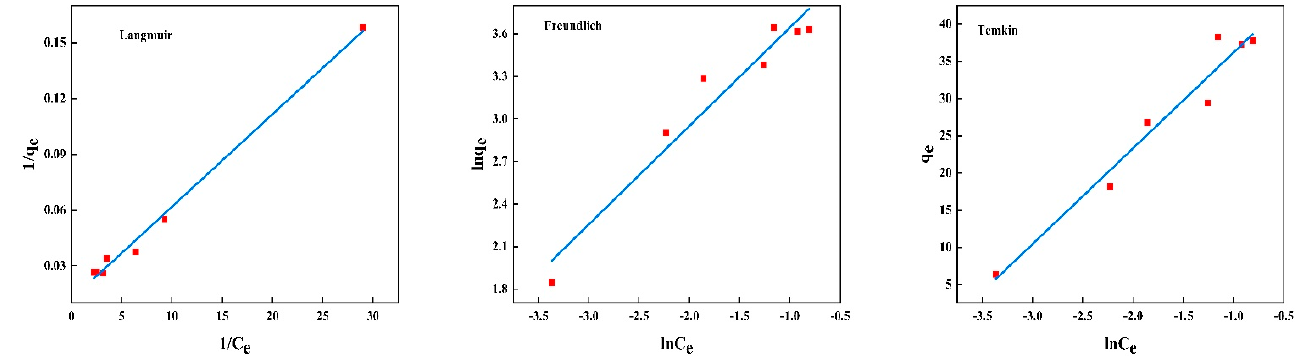
Figure 8. Model plot for linearly fitting isothermal adsorption.